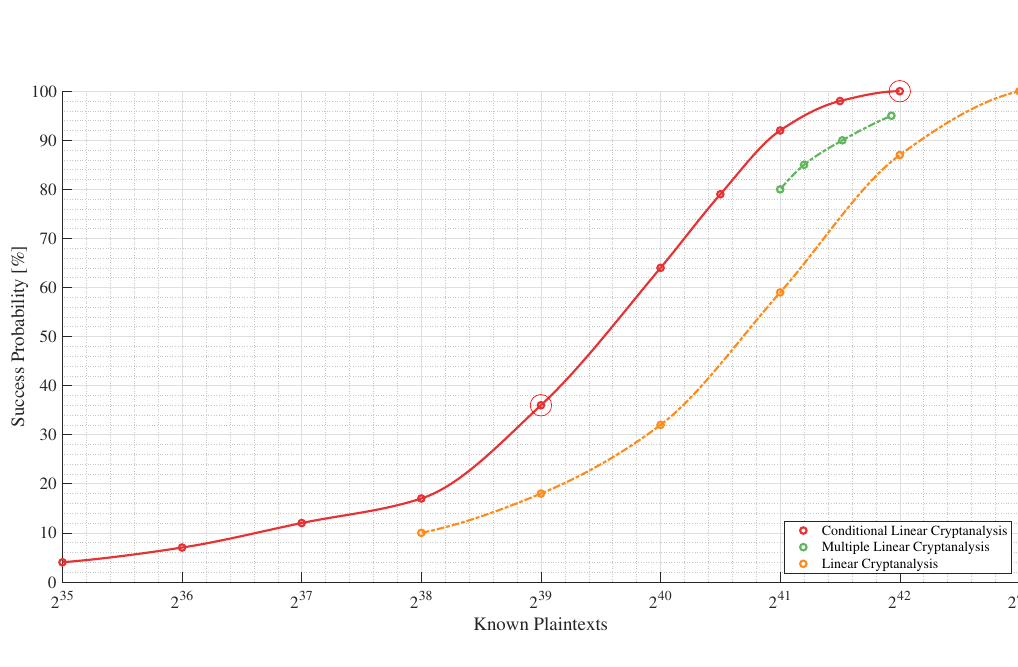
Figure 15: Comparison of the Success Probability by Number of Plaintexts for 2 50 Time of Analysis (The marked points were experimentally verified on 79 runs of our attack on the full 16-round DES).